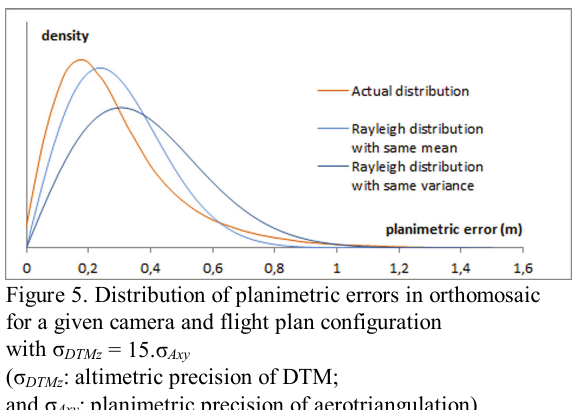
Figure 5. Distribution of planimetric errors in orthomosaic for a given camera and flight plan configuration with σ DTMz = 15.σ Axy